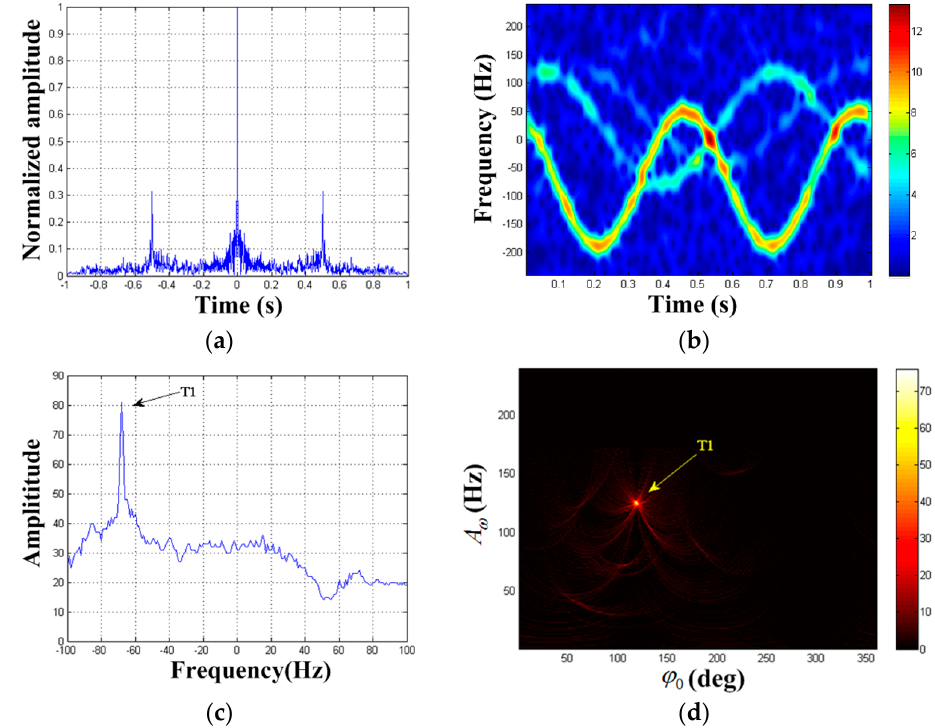
( ) x t Figure 5. Detection results of x ( t a ) . ( a ) Autocorrelation result of x ( t a ) ; ( b ) TF distribution result a